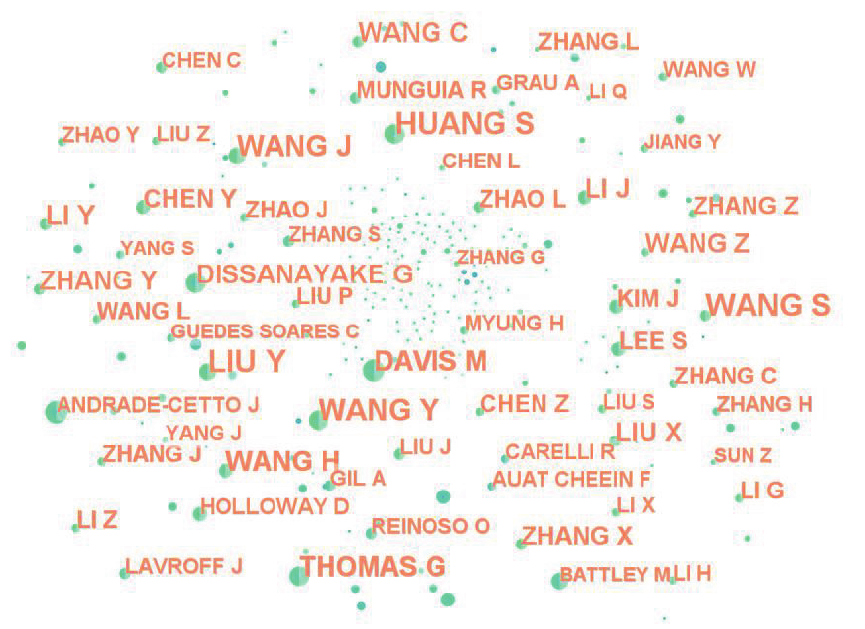
Figure 10. Main contributors of papers in the field of mobile robots.